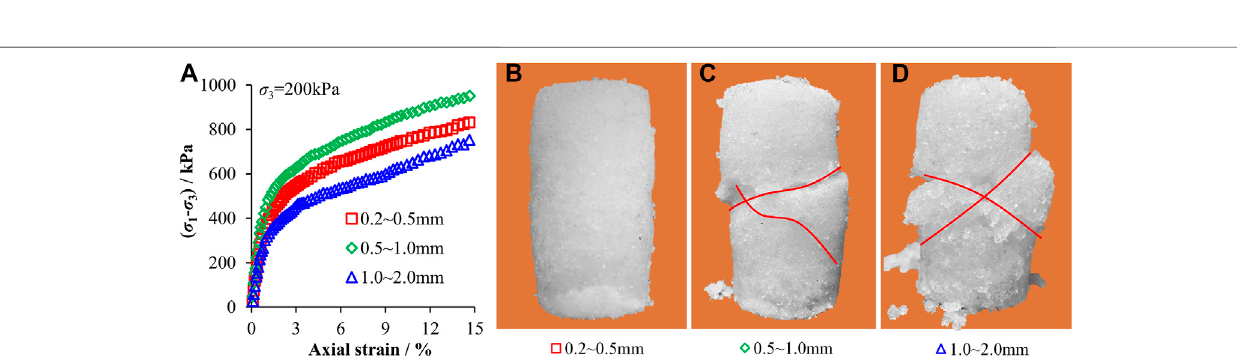
Frontiers in Materials |